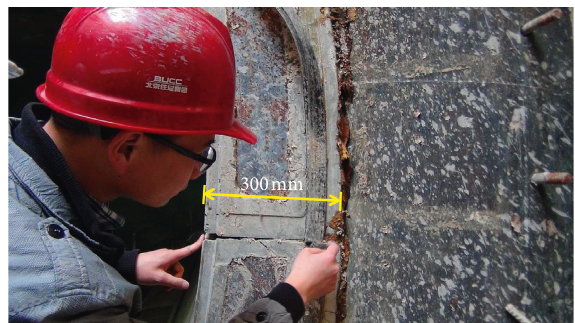
Figure 16: A realistic photo indicating the thickness of the precast concrete liner.